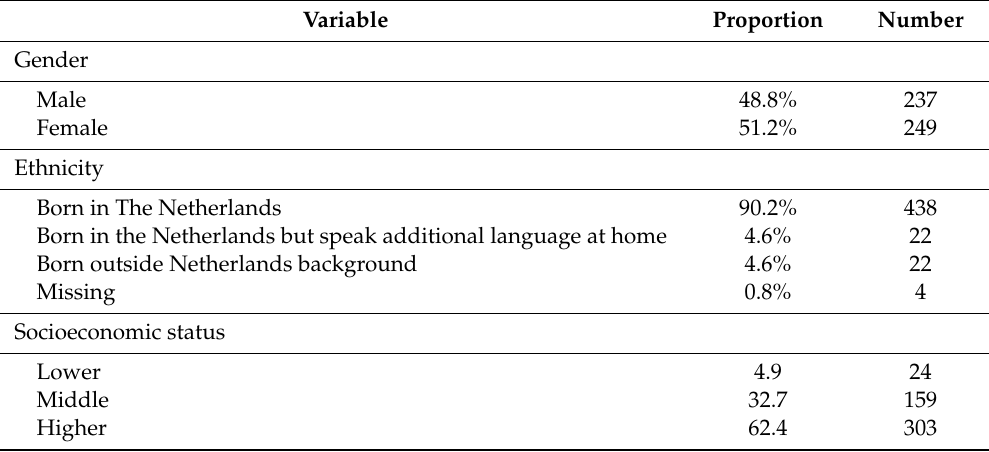
Table 1. Demographic characteristics of sample of completed CARIES-QC